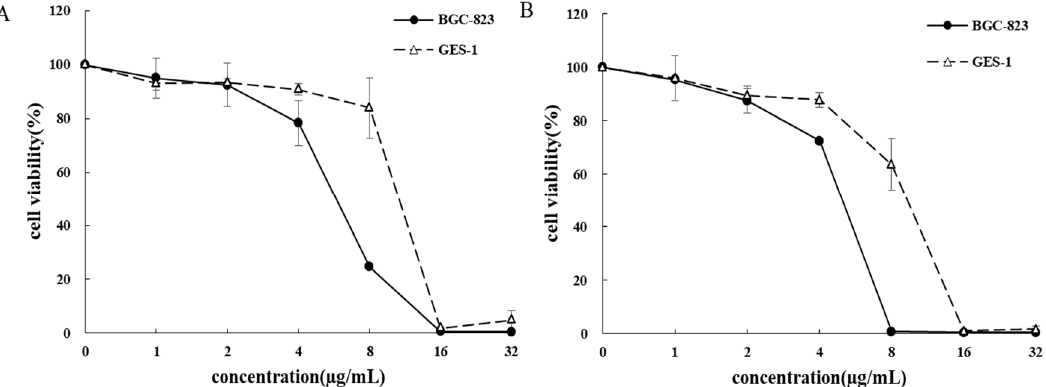
Figure 1. Effect of BB ( A ) and BC ( B ) on the proliferation of gastric cancer cells BGC-823 and gastric epithelial cells GES-1.